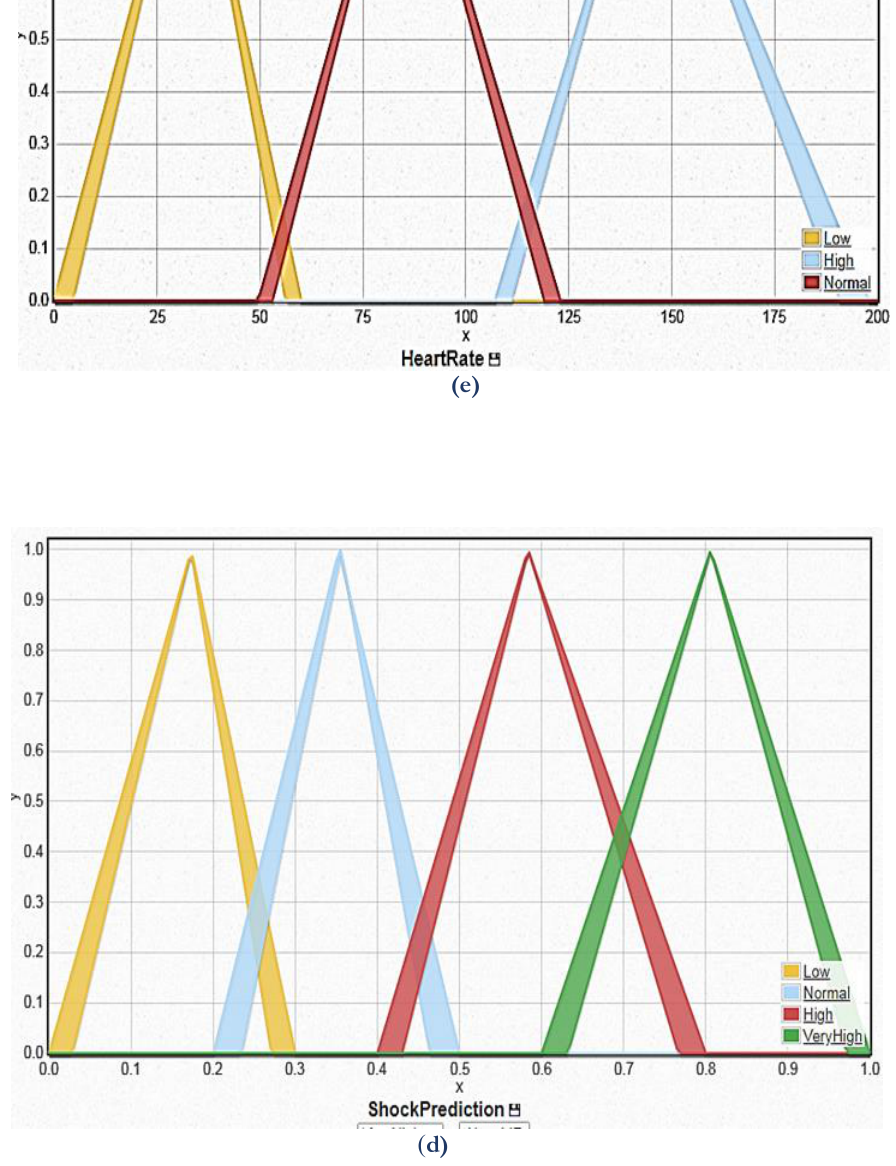
Fig. 7. Inputs and output membership functions plot for (a) bp-diastolic (b) bp-systolic (c) temperature (d) respiratory rate (e) heart rate and (f) shock level